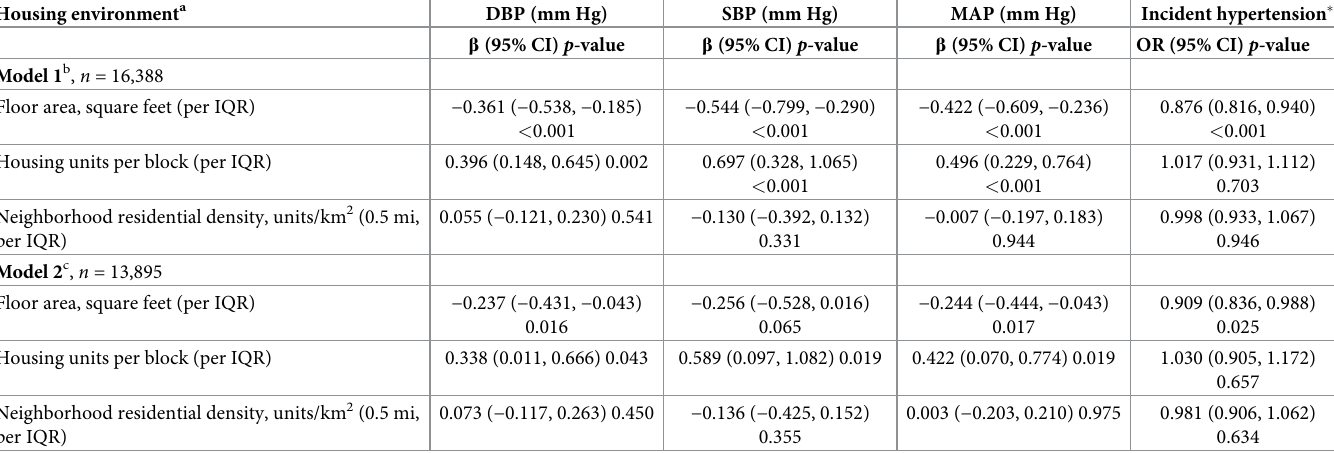
Table 4. Longitudinal association of housing environment exposures with blood pressure outcomes and incident hypertension among FAMILY Cohort participants aged 16 or above who were followed up and had not been diagnosed as hypertensives at baseline. Housing environment a